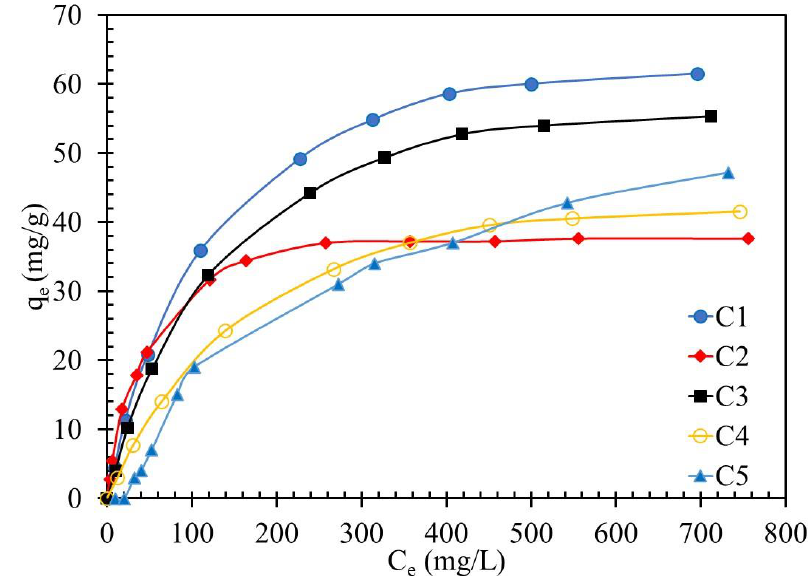
Figure 10. Adsorption isotherms of lead onto clays in the study; agitation speed (130 rpm), contact time 6 h, pH 6 and temperature 25 °C.